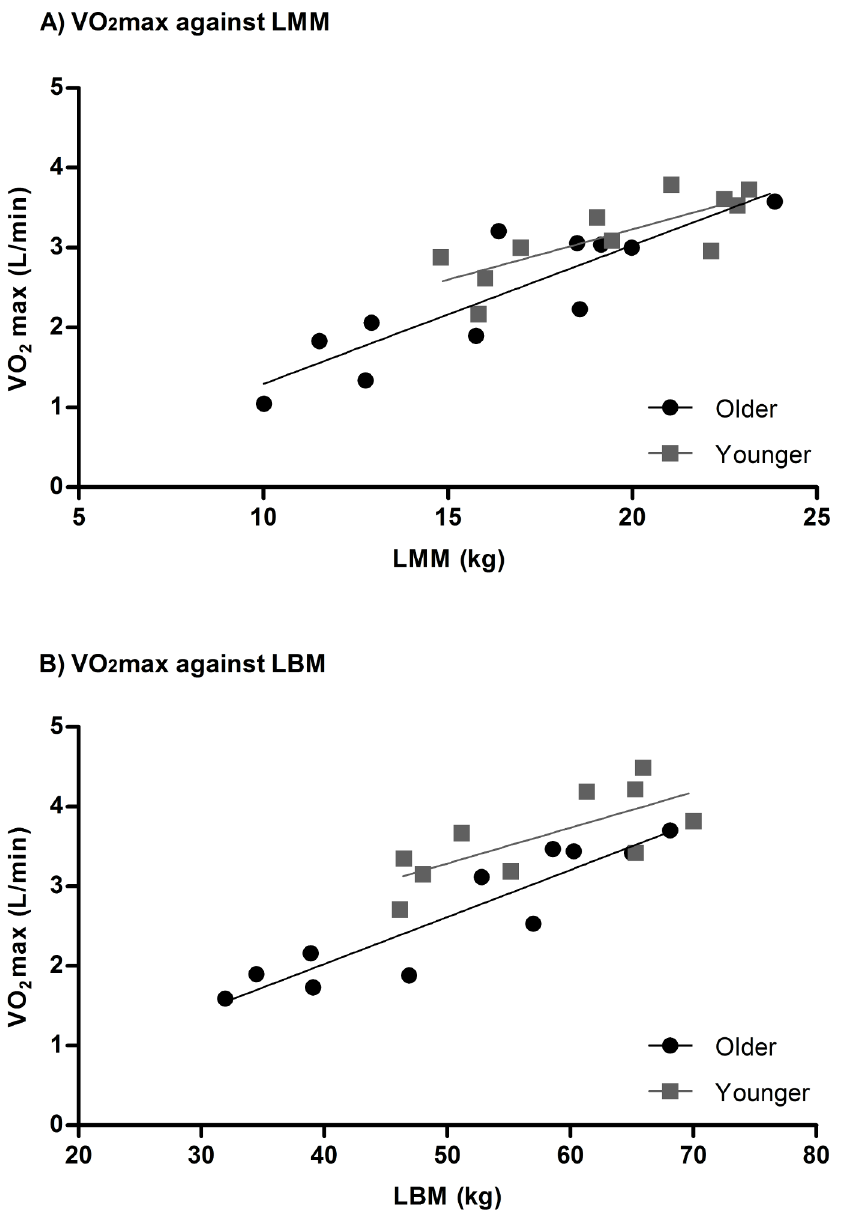
Fig 2. Individual VO 2 max against muscle mass. The slope of relationship between LMM and cycling VO 2 max was not significant different between older (y = 0.1737x-0.4418) and younger (y = 0.1263x+0.7057) subjects (p > 0.05). The slope of relationship between LBM and rowing VO 2 max was not significant different between older (y = 0.05907x-0.3382) and younger (y = 0.04480x+1.047) subjects (p >